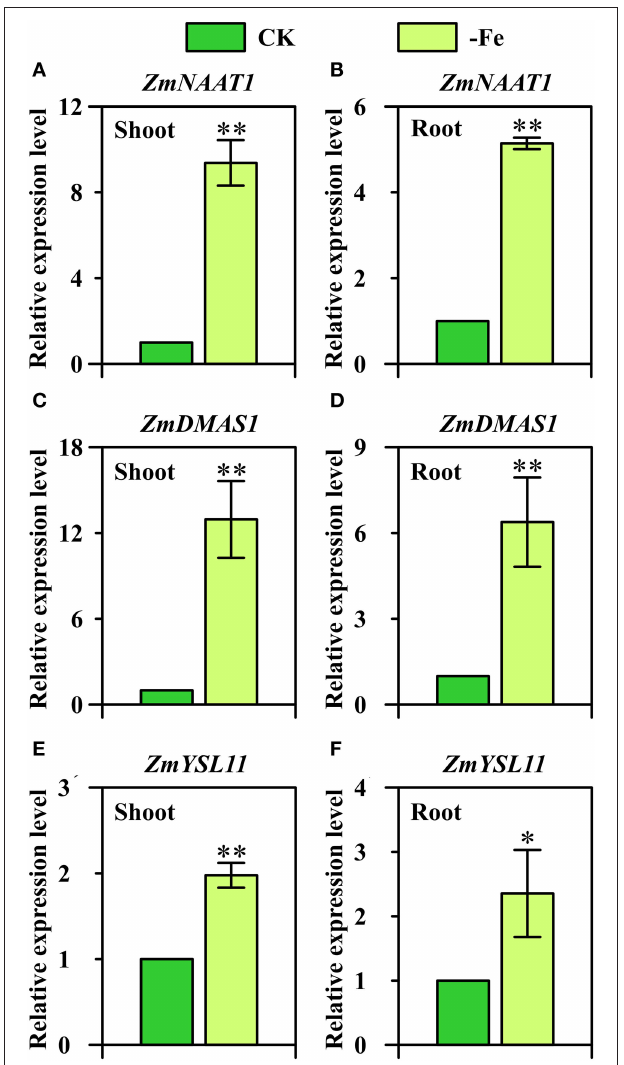
FIGURE 6 | Relative expression levels of strategy II genes (A,B) ZmNAAT1 (GRMZM2G096958), (C,D) ZmDMAS1 (GRMZM2G060952), and (E,F) ZmYSL11 (GRMZM5G812538) in the shoots (A,C,E) and roots (B,D,F) of Ye478 grown under Fe-deficient (-Fe) and Fe-sufficient (CK) conditions. * and ** indicate significant differences between treatments at P < 0.05 and P < 0.01, respectively.